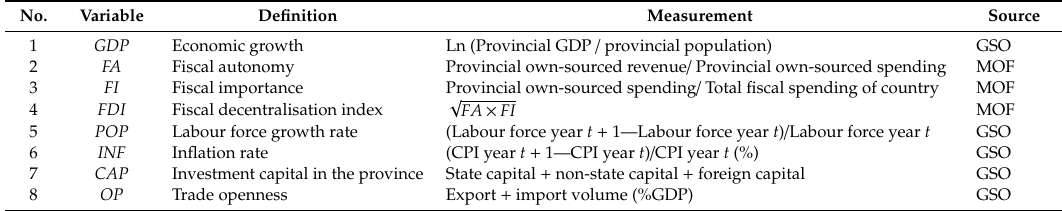
Table A1. Data source of variables.